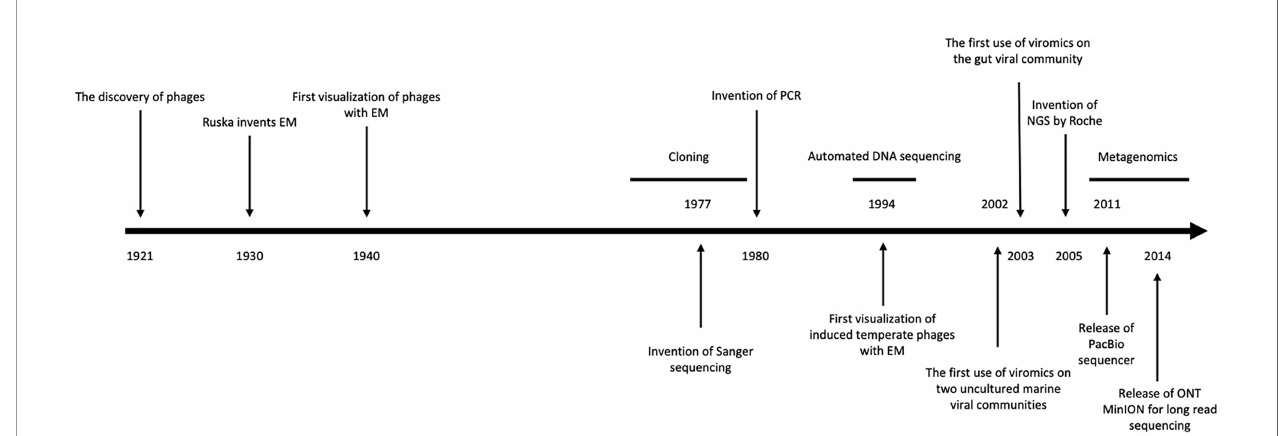
FIGURE 1 | Timeline of methodological discoveries. A summarised timeline including the invention of key tools for the study of phages, from their discovery in 1921 to recent modern metagenomic sequencing technologies. Adapted from Mokili et al. (2012).